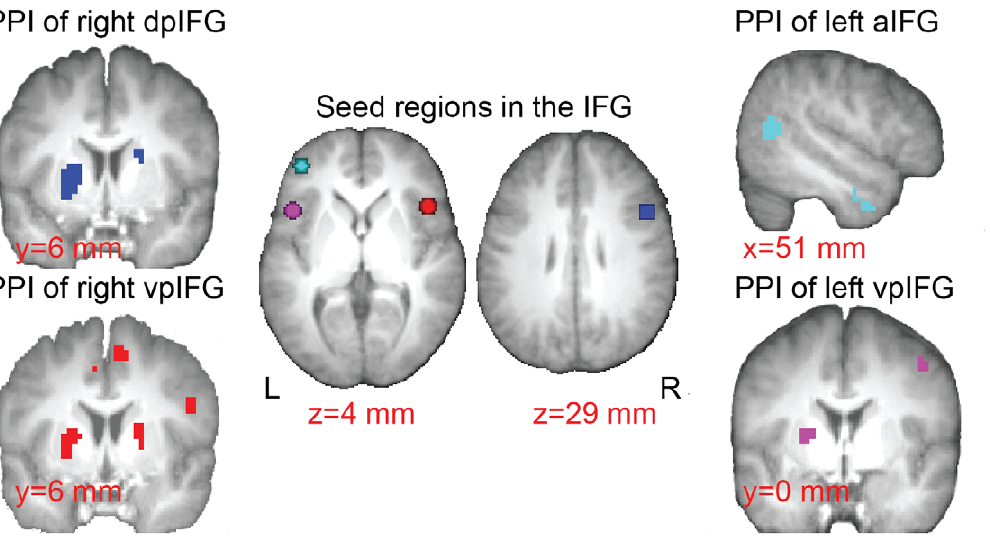
Figure 4. Psychophysiological interactions of IFG subregions during response control. The images in the center illustrate the IFG subregions on the axial slices. The functional connectivity of each IFG region during the response blocks of SST versus NST is shown on the side (neurological orientation: right=right). The right dpIFG (average MNI coordinates: x=51, y=14, z=29) showed stronger interactions with the striatum. The left aIFG (x= 2 42, y=46, z=7) showed stronger interactions with the right middle temporal gyrus. The right vpIFG (x=47, y=20, z=0) showed stronger interactions with striatum, premotor cortex and supplementary motor area. The left vpIFG (x= 2 47, y=17, z=0) showed stronger interactions with striatum and premotor cortex. All PPI maps were presented at threshold of p , 0.001, uncorrected. Abbreviations: aIFG: anterior inferior frontal gyrus; vpIFG: ventral-posterior IFG; dpIFG: dorsal-posterior IFG.